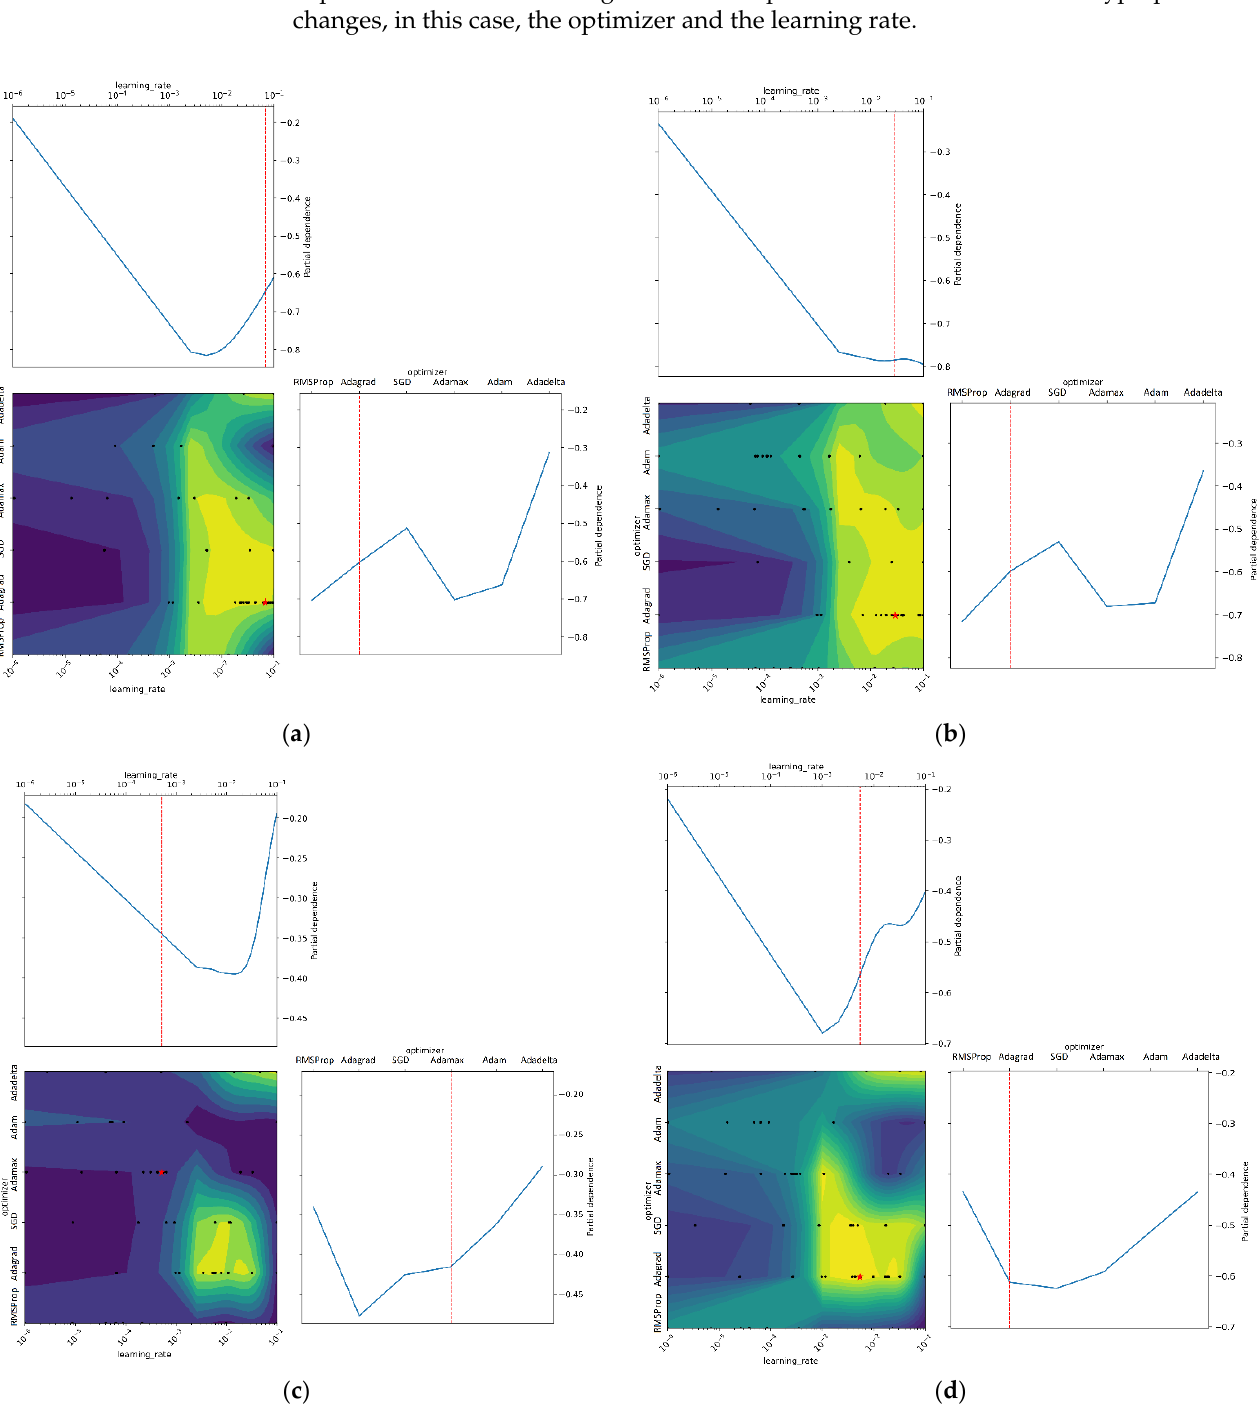
Figure 11. Partial dependence plots obtained for each combination of hyperparameters, with Bayesian Optimization applied to the selected CNNs. Red points and lines are the best hyperparameter combination for each model. ( a ) MobileNet, ( b ) SqueezeNet, ( c ) NasNetMobile, and ( d ) MobileNetV2.